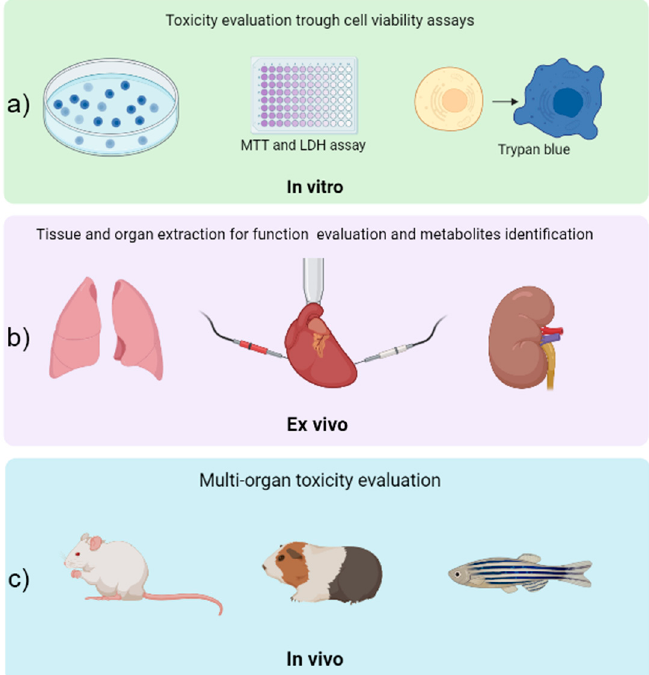
Figure 6. Toxicological assays and protocols help researchers to better understand the impact of novel pharmaceutical agents and materials: ( a ) in vitro, ( b ) ex vivo, and ( c ) in vivo.